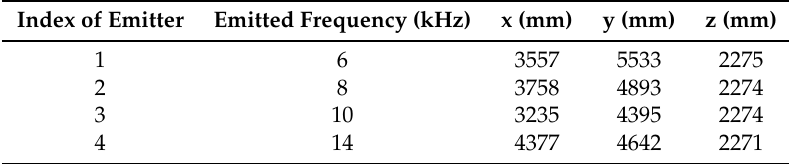
Table 1. Coordinates of the emitters’